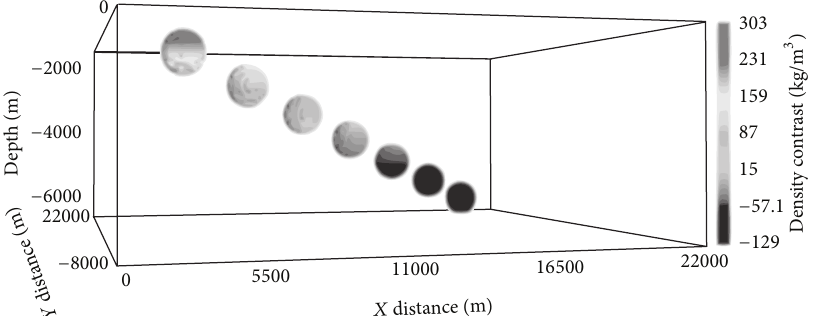
Figure 6: Synthetic problem setup with 7 spheres of variable density contrast (not scaled). Ensemble size of 22 km × 22 km × 8 km, 251,946 conform the spheres.